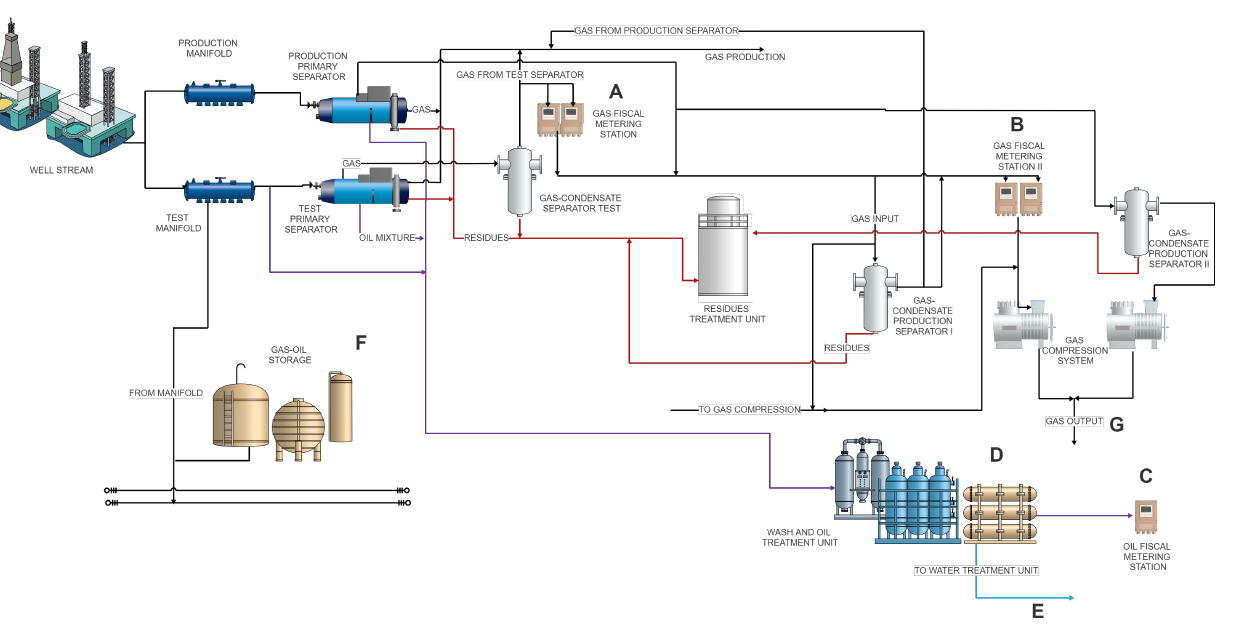
Figure 1. Oil and gas metering station PFD.